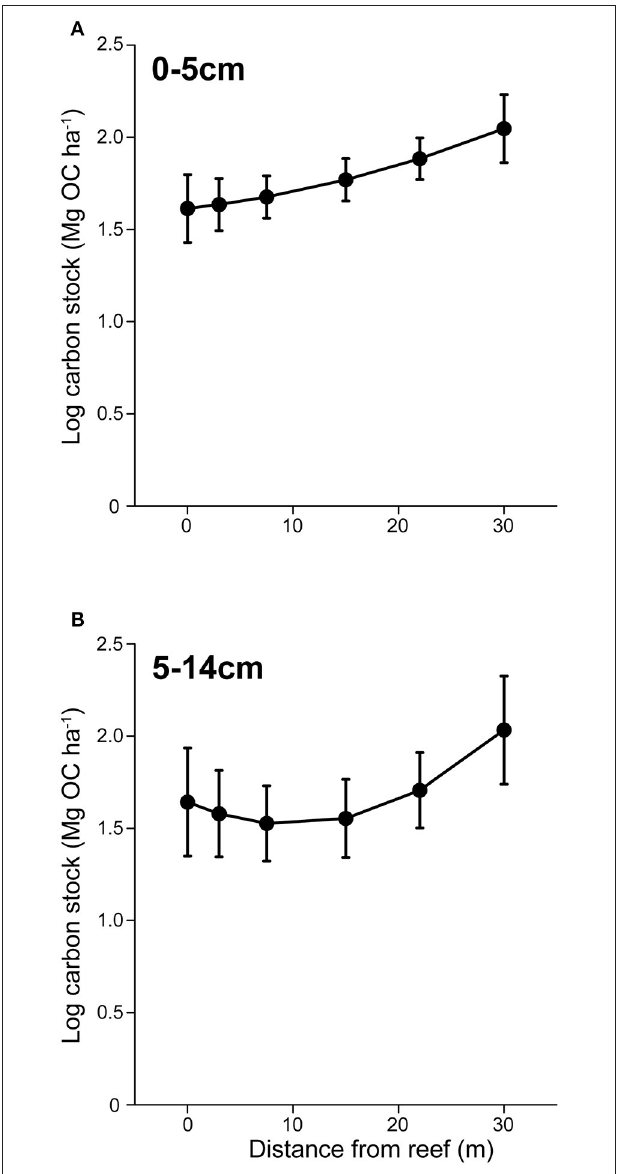
FIGURE 4 | Sedimentary carbon storage in a seascape of fear. (A) Mean ( ± s.e.) sedimentary organic carbon (OC) in surface (0–5cm) sediments with increasing distance from herbivore refuges. (B) Mean ( ± s.e.) sedimentary OC stocks in subsurface (5–14cm) sediments with increasing distance from herbivore